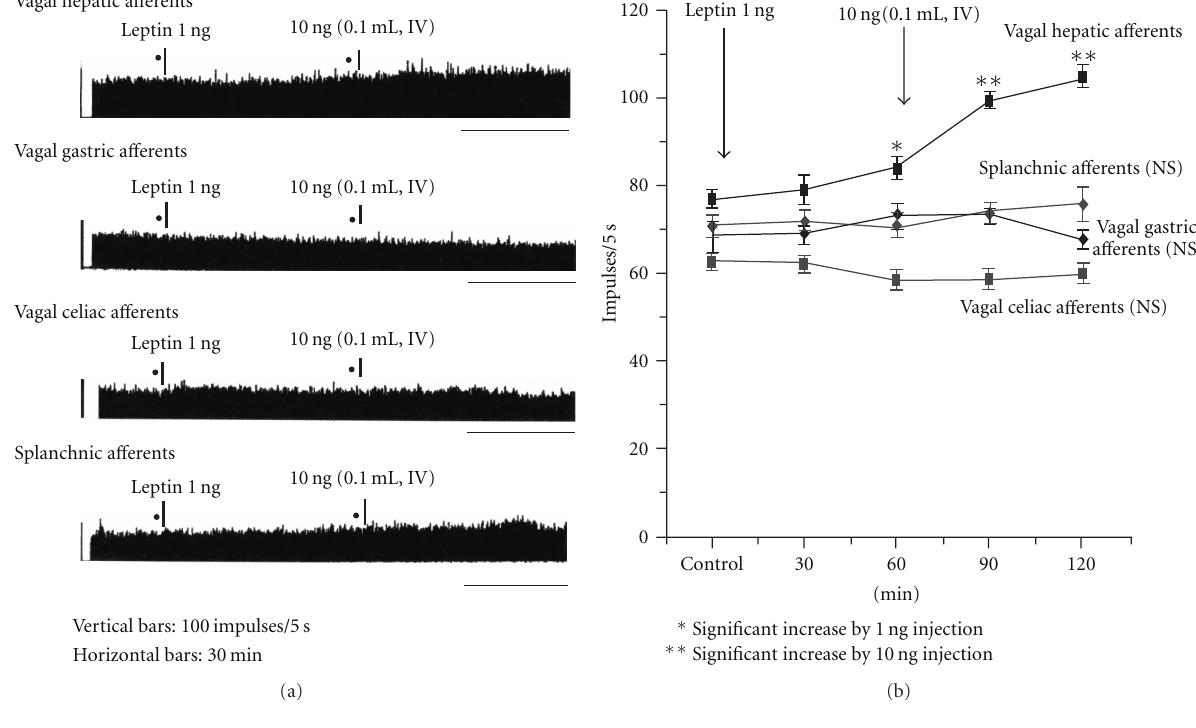
Figure 1: E ff ect of intravenous (IV) injection of leptin (1ng and 10 ng, 0.1mL) on the a ff erent discharge rate of the hepatic, gastric, or celiac branch of the vagus nerve, and that of the splanchnic